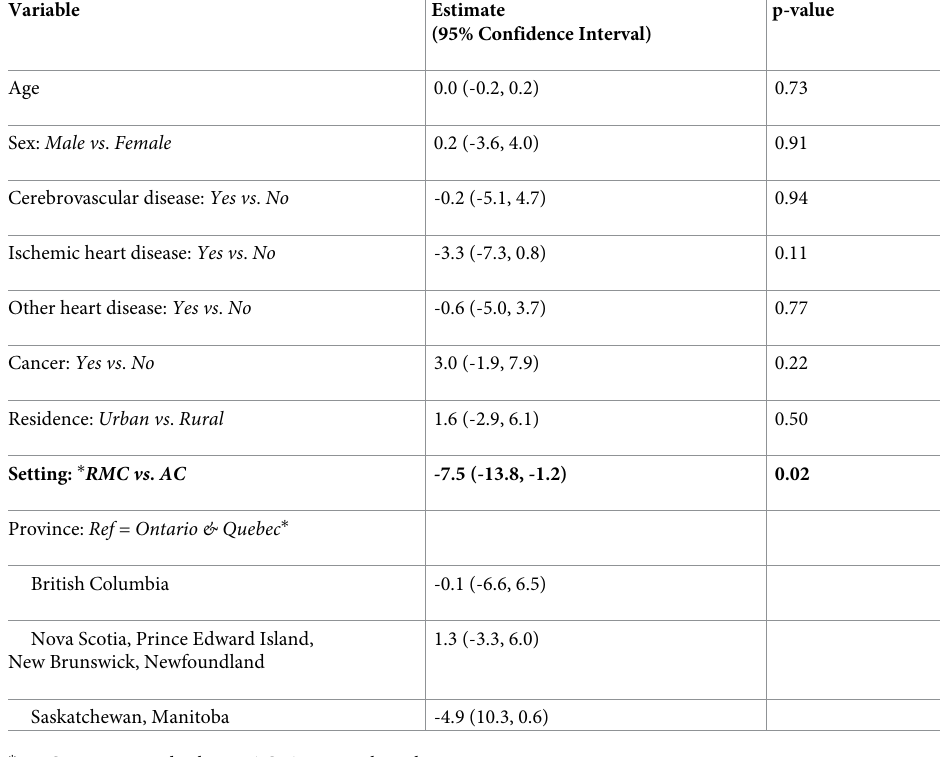
Table 5. Results from multivariable linear regression (Outcome = TTR, n = 501). Variable